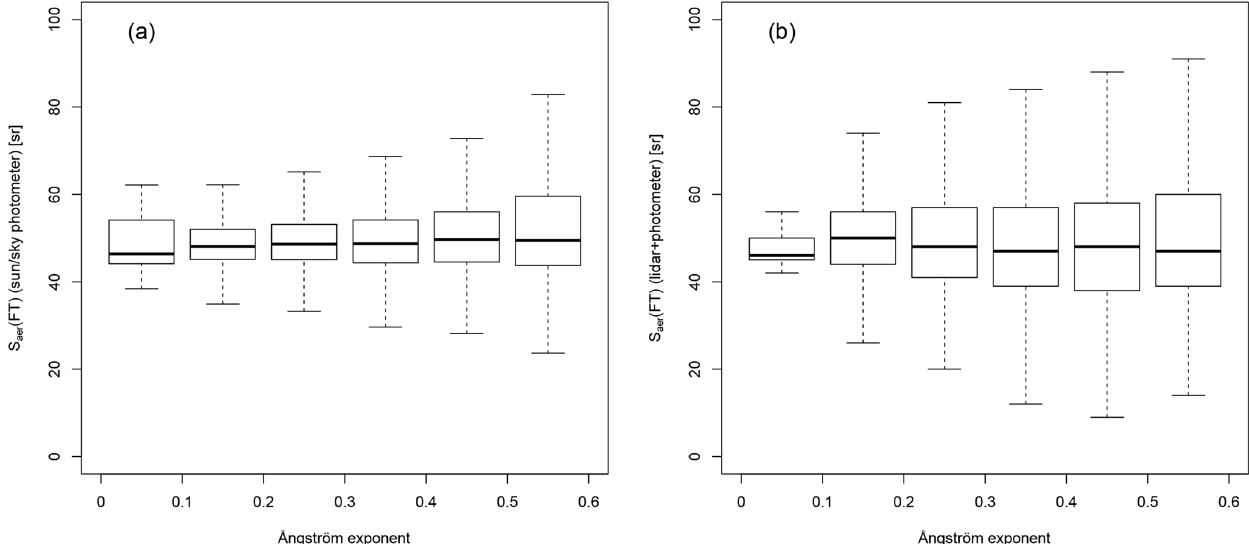
Figure 17. Lidar ratios at 523nm for mineral dust conditions ( α < 0 . 6) obtained from (a) the sun–sky photometer installed at Izaña and from (b) two-layer inversion for the FT for different Ångström exponent intervals. The central rectangles extend from the first quartile to the third quartile and the median is represented by a horizontal line. The whiskers are defined as the upper and lower quartiles ± 1.5IQR (interquartile